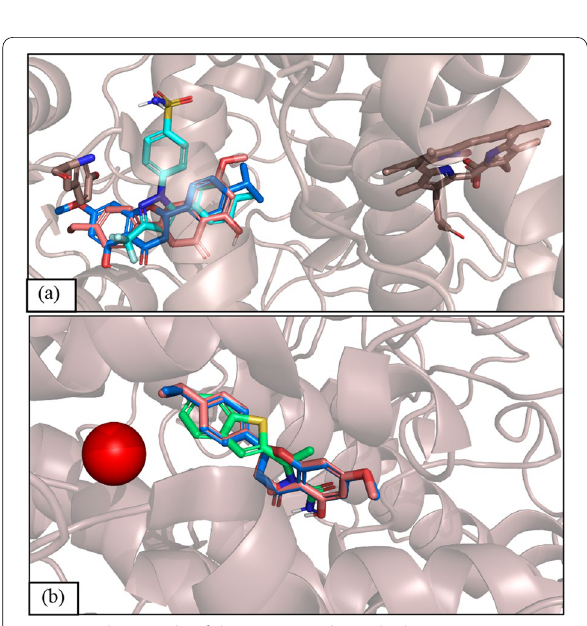
Table 3 5-LOX inhibition of the tested compounds Compounds